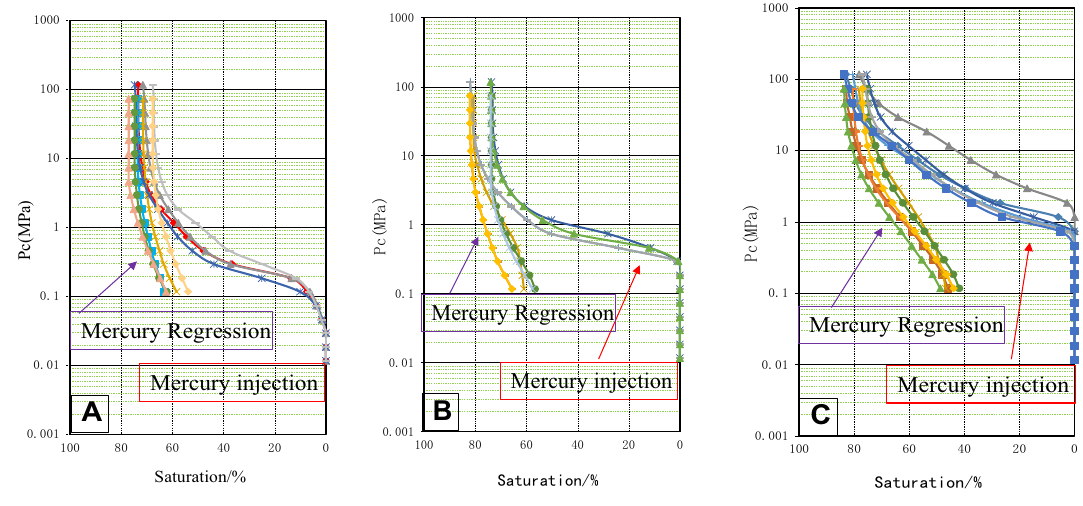
Fig.6 Classification of pore structure ( A : Type-I; B : Type-II; C : Type-III)